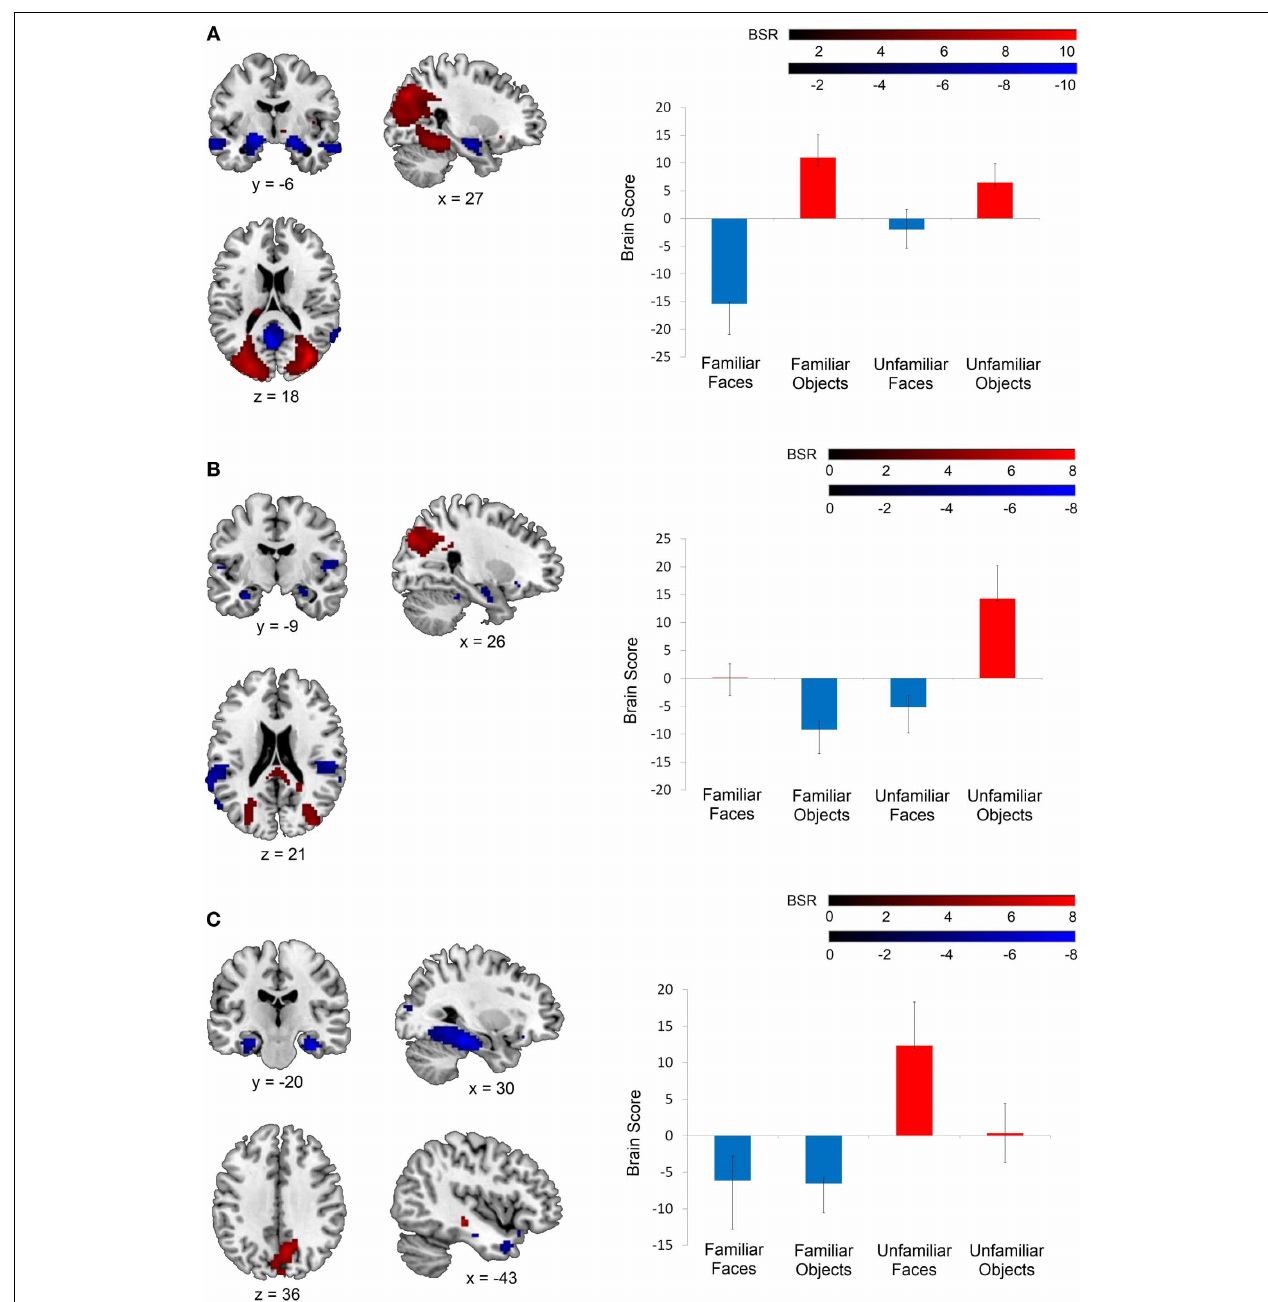
FIGURE 2 | Latent variables identified in the mean-centered task PLS analysis. On the left, voxel salience maps are shown. On the right, bar graphs for each of the three LVs illustrate the extent to which each condition corresponds to each of the positively-weighted (shown in red on brain images) and negatively-weighted (shown in blue on brain images) networks. These networks, in the form of voxel salience maps for each LV, are all shown for TR 3, superimposed on the ch2bet template in MRIcron